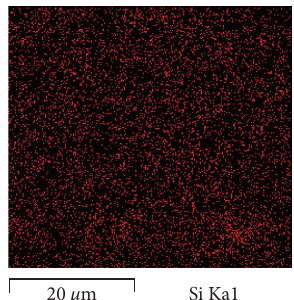
Figure 5: SEM/EDX image for SiO